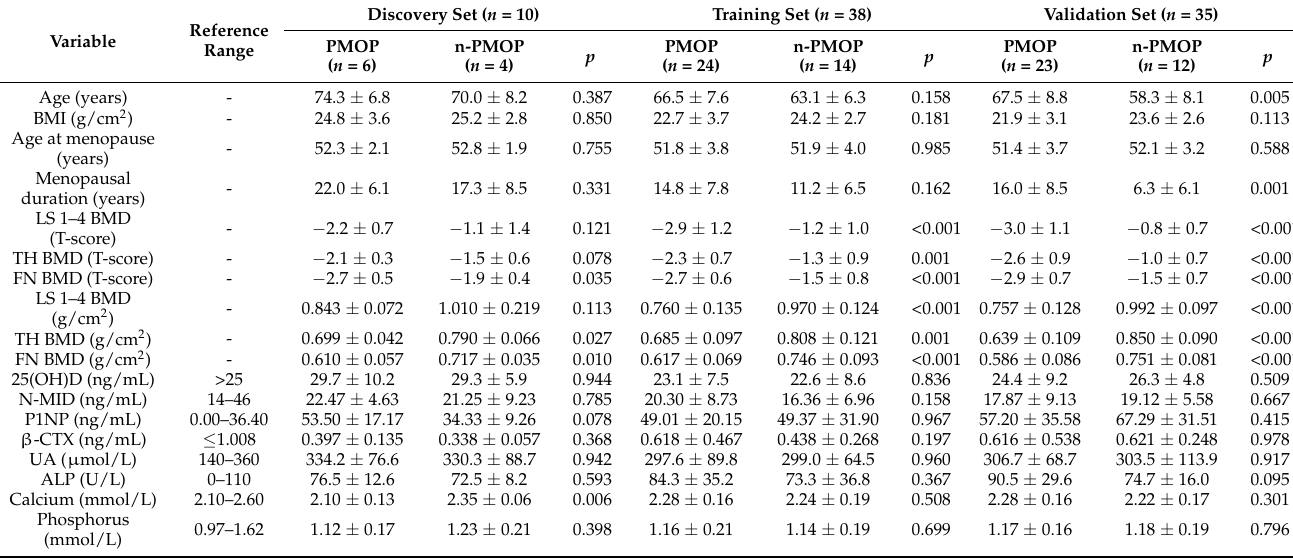
Table 1. General clinical data, serum BTMs, and biochemical indices of participants.